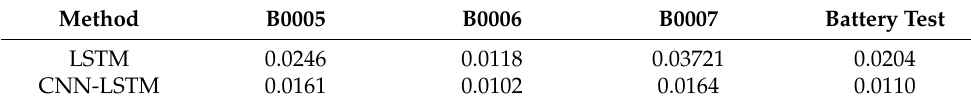
Table 6. RSME comparison results.